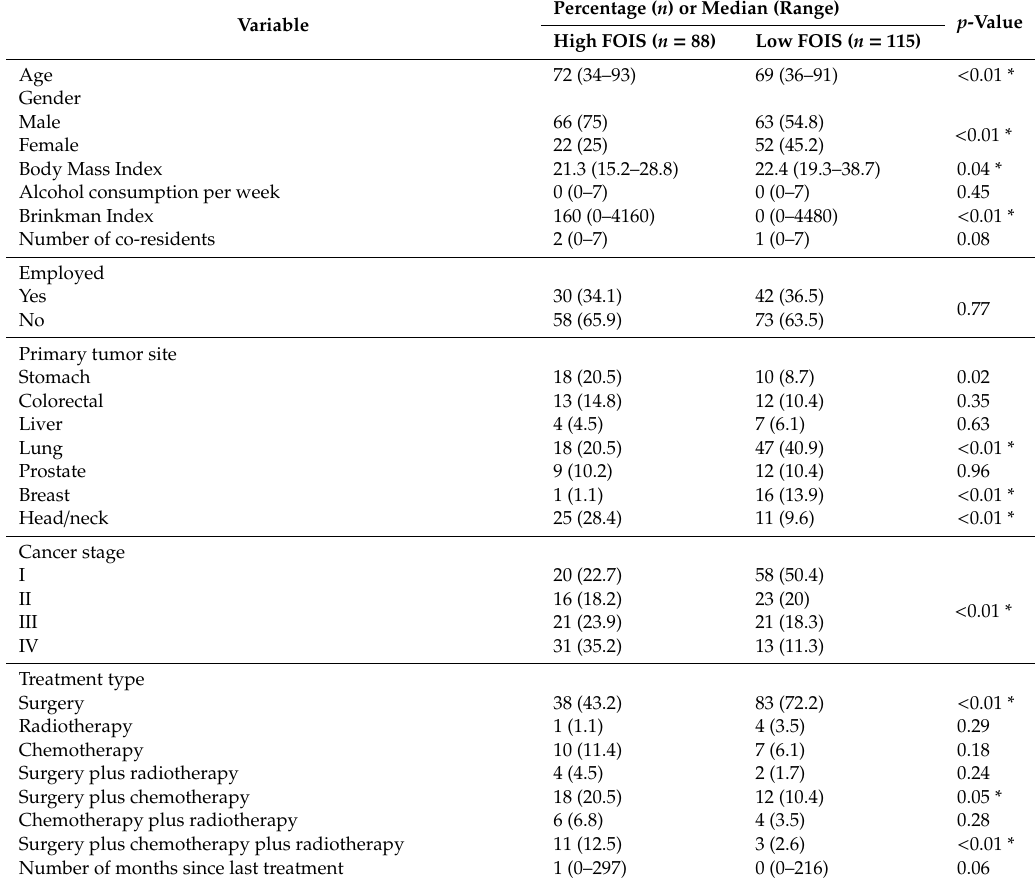
Table 3. The comparison of the high versus low FOIS analysis of each